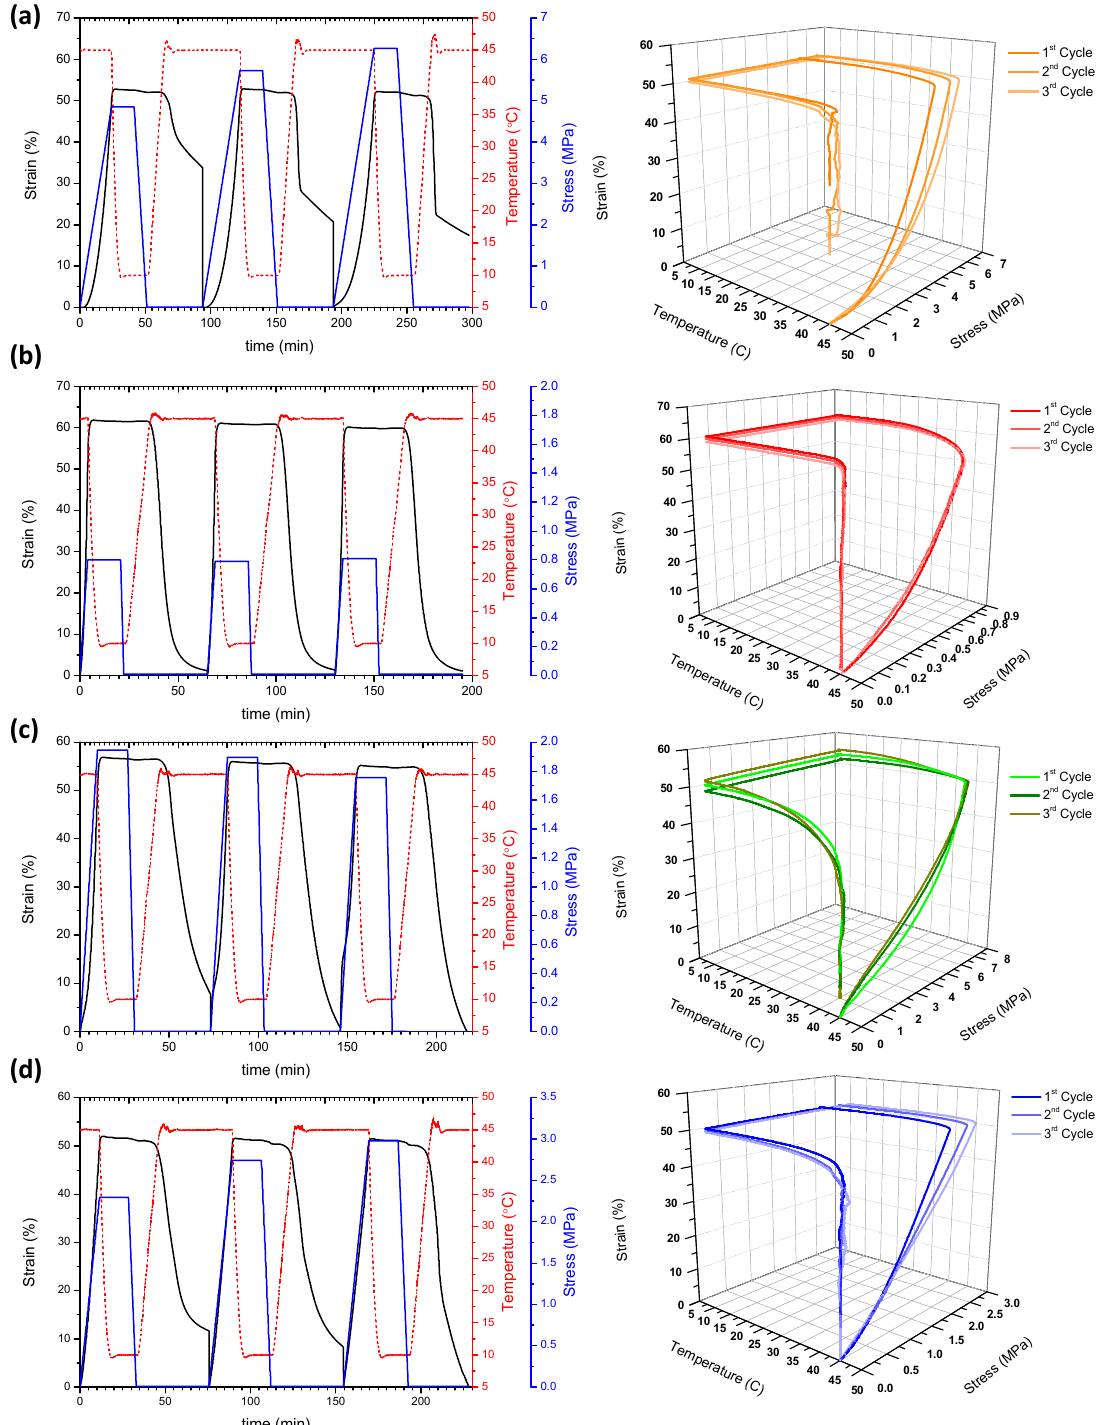
Figure 6. 2D and 3D thermo-mechanical cycles performed at 45 ° C for ( a ) neat PLA/OLA and its nanocomposites containing ( b ) 0.5 wt.% of AgCH-NPs, ( c ) 1 wt.% of AgCH-NPs and ( d ) 3 wt.% of AgCH-NPs.